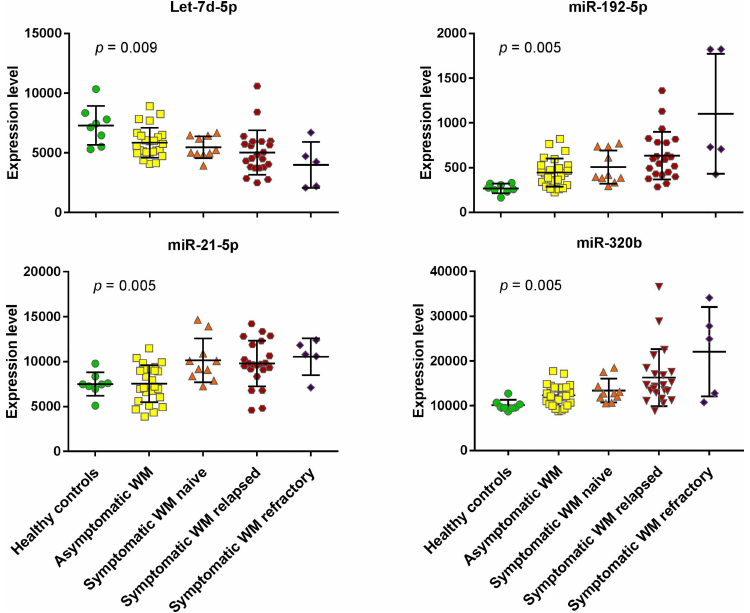
Fig 3. Exosomal miRNAs correlating with WM progression. A) Distribution (Mean + SEM) of microRNA expression in Healthy Controls or WM patients at progressive stages of disease measured by the Abcam Firefly Multiplex circulating miRNA assay (33-plex). Significance was assessed by a one-way ANOVA ( p < 0.01) and a test for linear trend ( p- for-trend < 0.005) with Benjamini-Hochberg correction applied for False Discovery Rate adjustment.